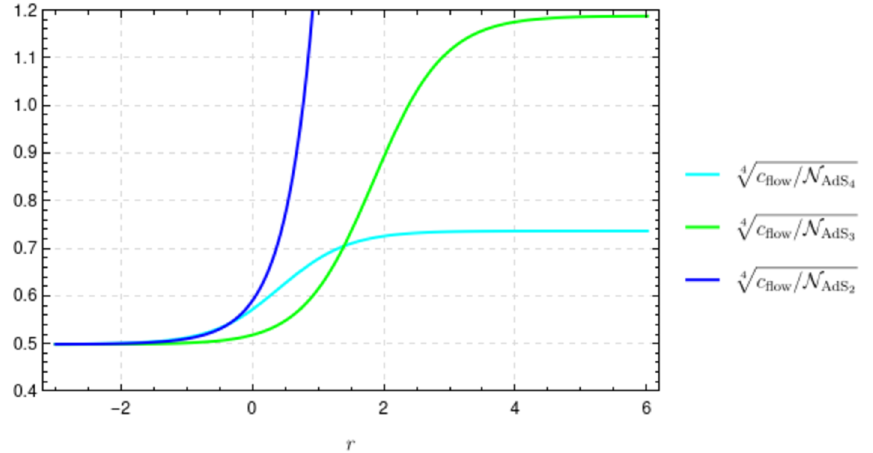
Figure 4 . Plot of the flow central charge for the BPS solutions discussed in figures 1, 2 and 3. We have chosen G = 1 . The monotonicity of this quantity is clearly N